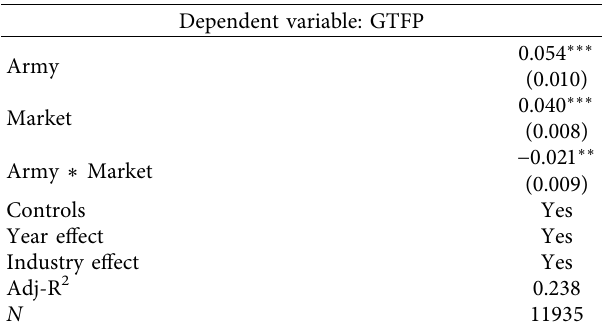
Table 6: Moderating efect of formal